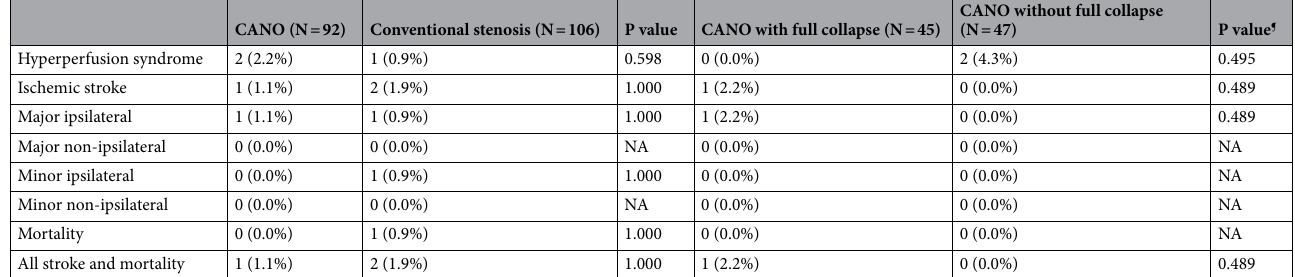
Table 3. Clinical outcomes. Ischemic stroke was categorized as major stroke if the National Institute of Health Stroke Scale (NIHSS) score was ≥ 9, or as a fetal or disabling stroke. ¶ P value of comparing CANO patients with and without full